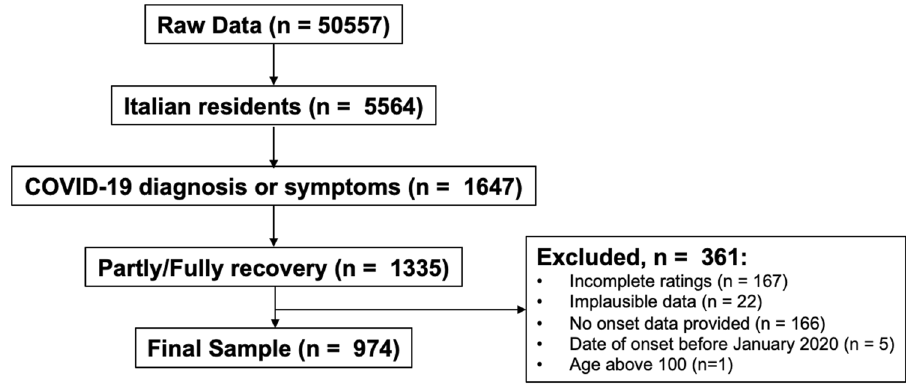
Figure 5. Flow diagram presenting the selection of the observations included in the present